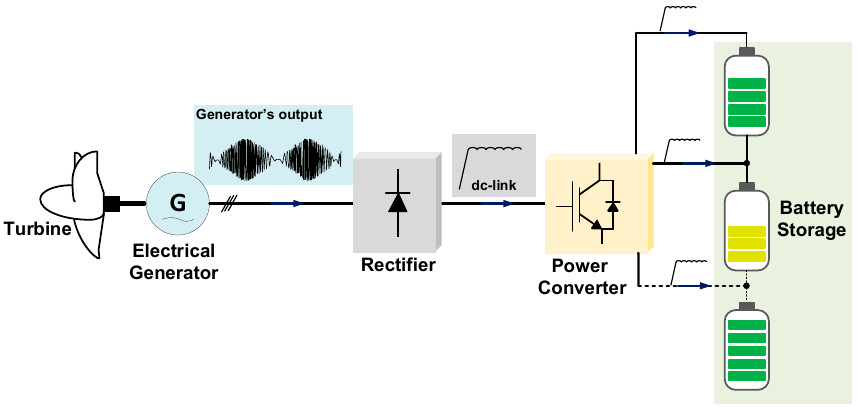
Figure 2. Power transfer from MES to the battery storage system.